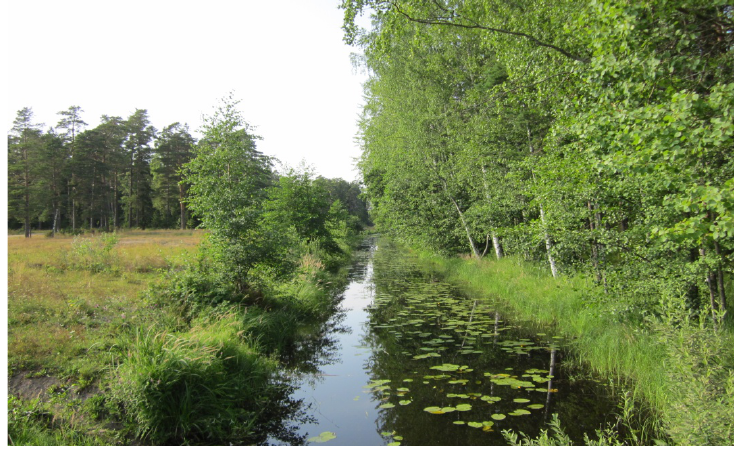
Figure 2. – Valaam. Jordan River (canal)